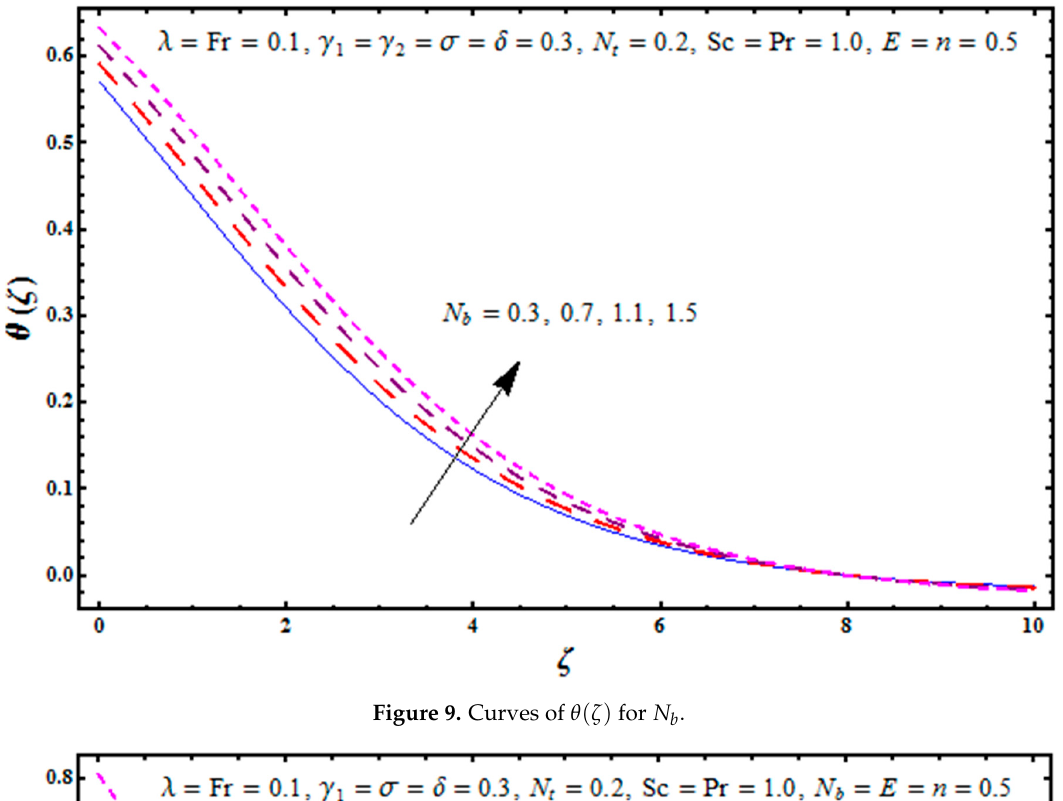
Figure 9. Curves of θ ( ζ ) for N b .